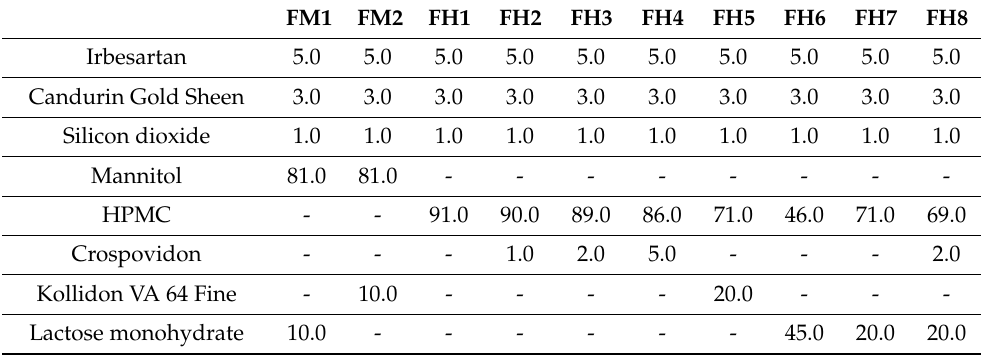
Table 1. Composition (% w / w ) of the initial